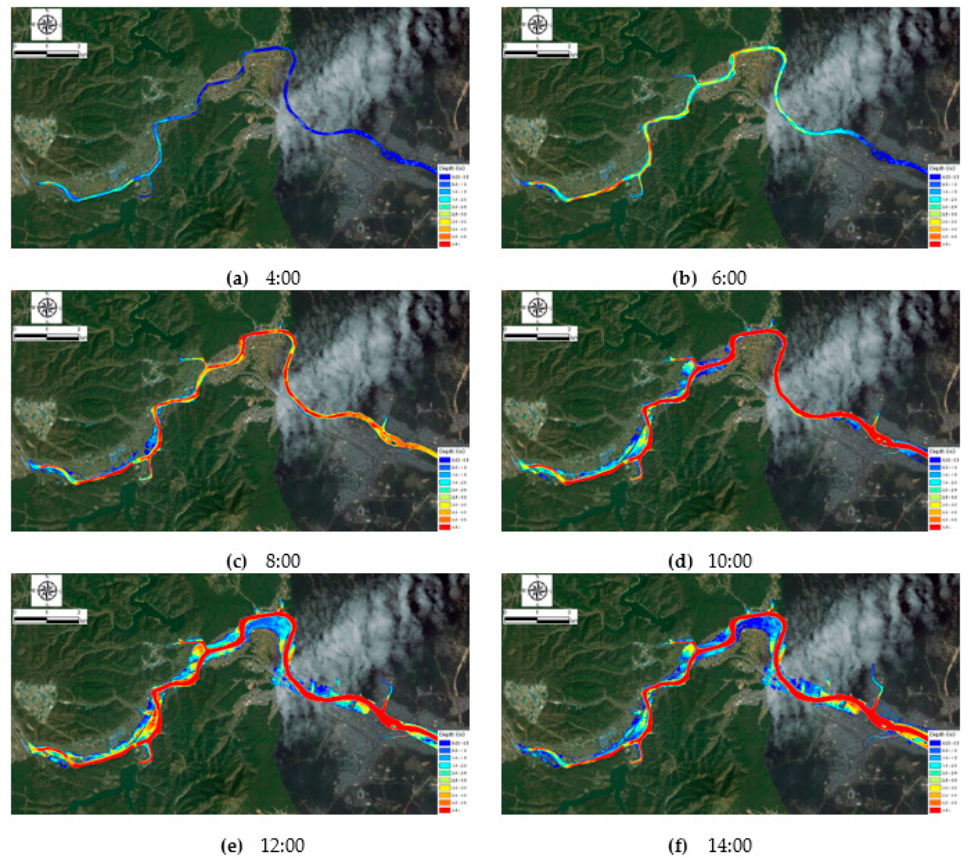
Figure 11. Flood extent and depth over time evolution for the No. 92 h scenario (see Table 1).